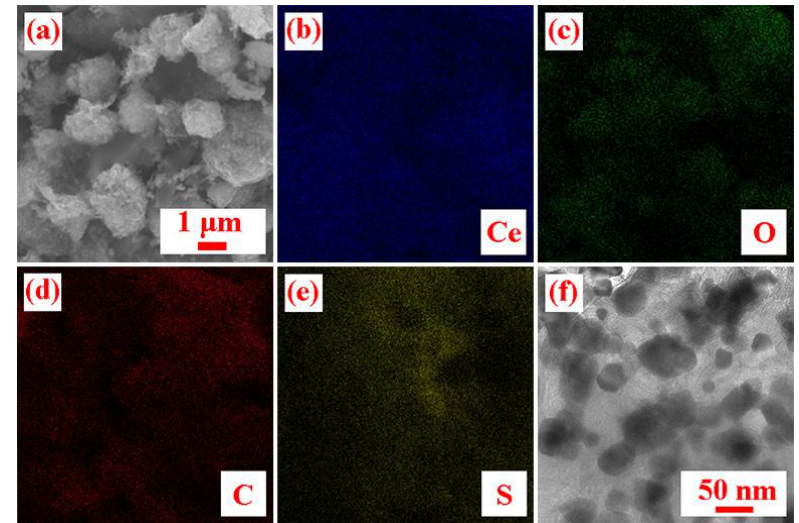
Figure 5. ( a ) SEM image of S/CeO 2 /RGO. ( b – e ) Element mapping of S/CeO 2 /RGO. ( f ) TEM image of S/CeO 2 /RGO.